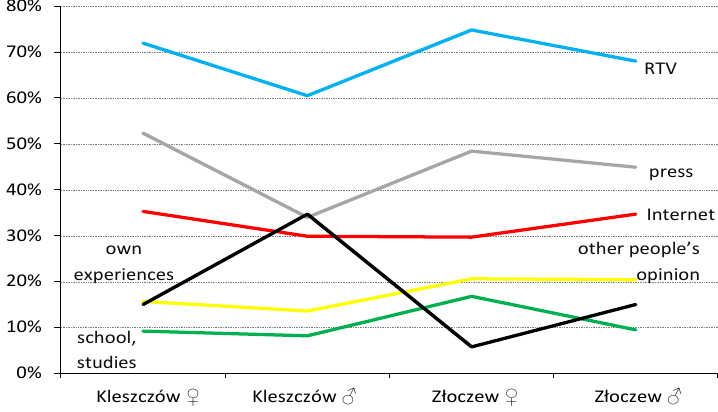
Fig. 4. What is your main source of information about resources excavation? Please indicate three from among the given ones. The inhabitants of the Złoczew community (n = 302) divided by age groups (Source: Telephone interviewing (CATI), January-